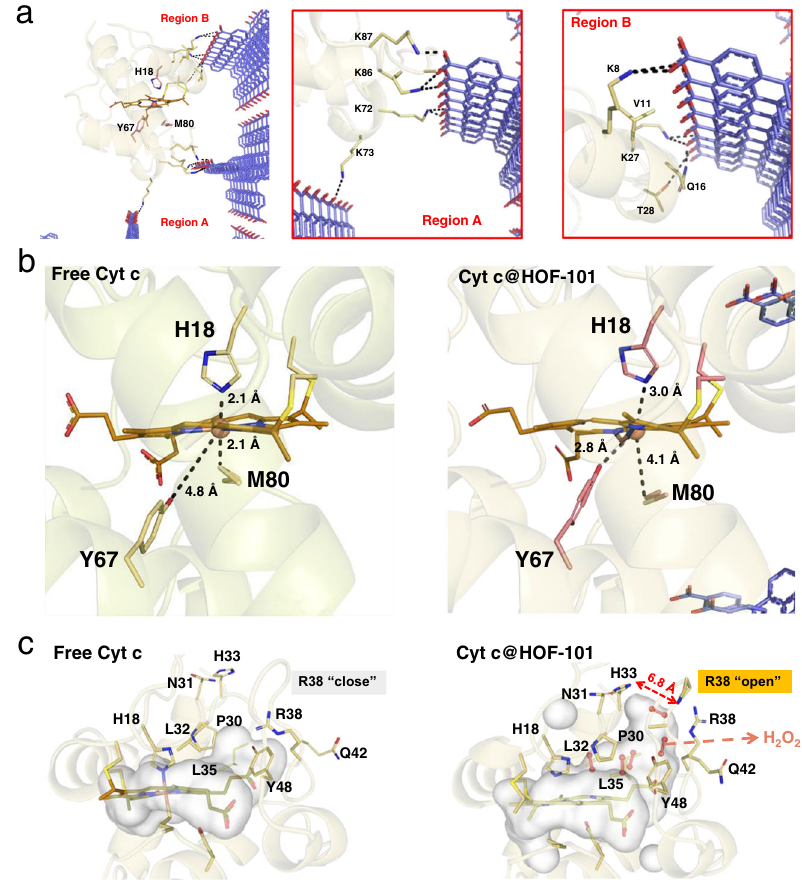
Fig. 5 | Insight into the conformation change by computational simulation. a The typical H-bonded interactions between the Cyt c surface residues and the – COOHgroupsofHOF-101. b ThemicroenvironmentsofhemecenterofnativeCyt c and Cyt c@HOF-101. c The binding cavities of native Cyt c and Cyt c@HOF-101, wherein the open pocket (R38) in Cyt c@HOF-101 facilitated the entrance of H 2 O 2